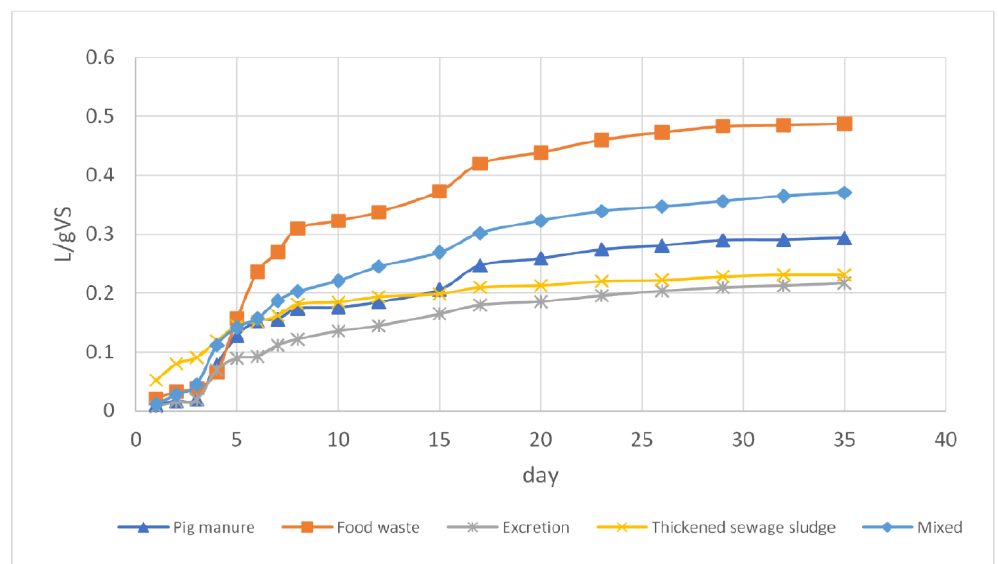
Figure 1. Cumulative biogas production (BMP test).